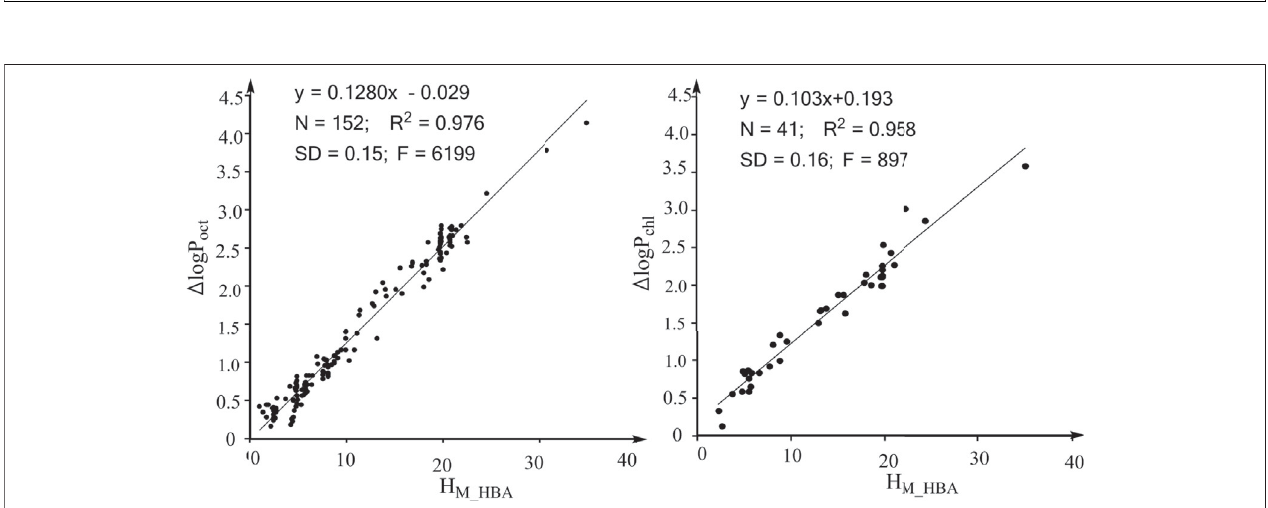
FIGURE2| StronglinearassociationsbetweentheeffectsofHBAsonpropertiesandHM_HBA.H M_HBA :overallH-bondingcapabilitiesoftheHBAsofasolute. (A) Forthe property logP oct (log ofthe partition coef fi cient betweenn-octanolandwater). (B) Fortheproperty logP chl (logofthepartitioncoef fi cient between chloroform and